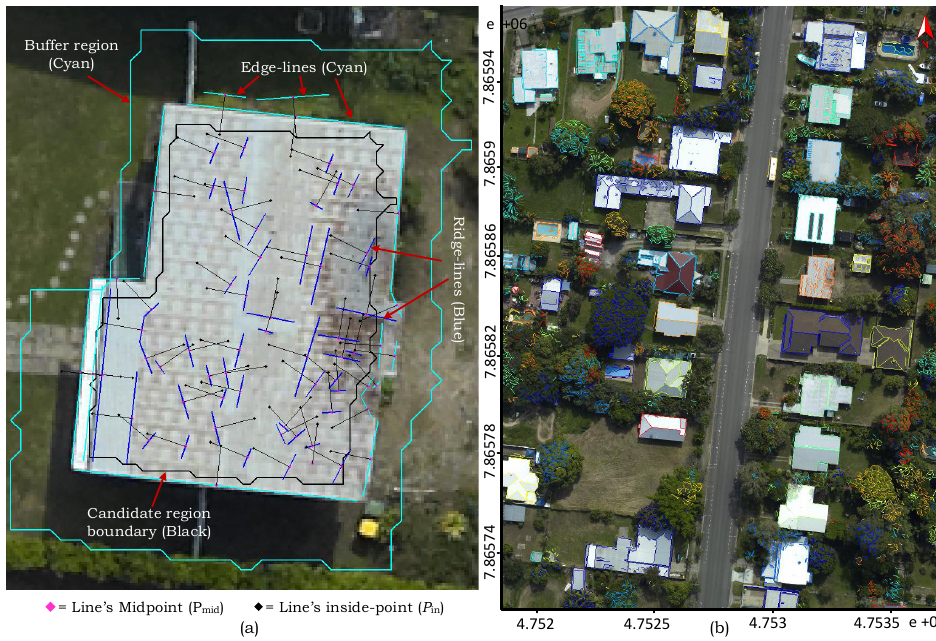
Figure 7. Line clustering process: ( a ) Pool of Candidate lines to a sample building; ( b ) Clusters found with their associated lines in different clustering